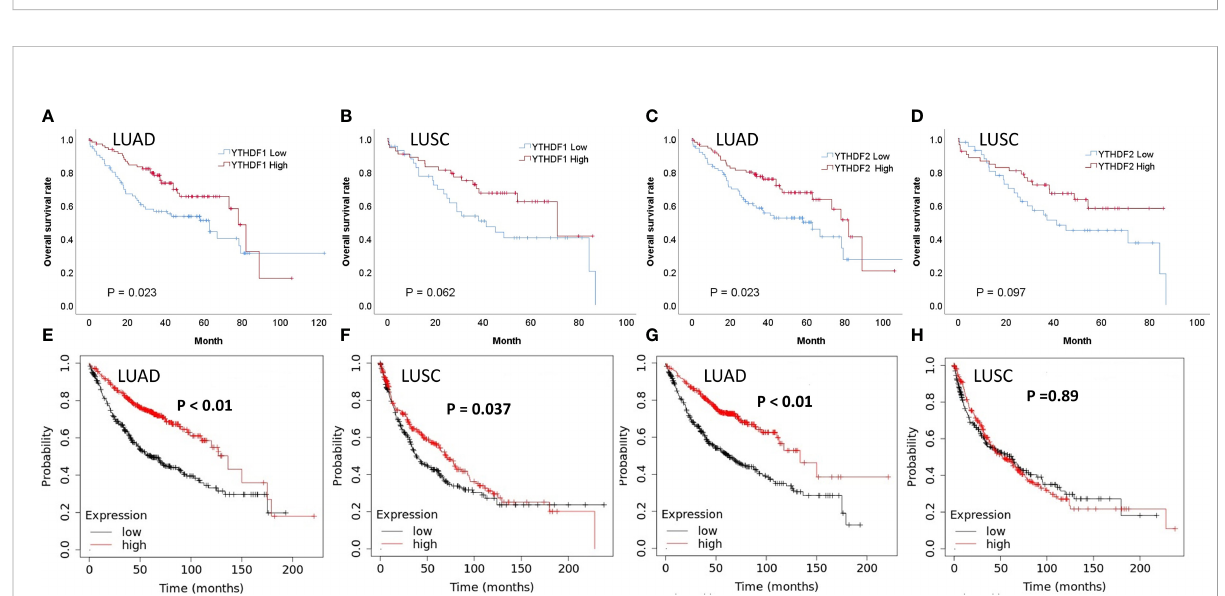
FIGURE 4 Survival analyses according to YTHDF1 and YTHDF2 expression in patients not receiving PD-1/PD-L1 inhibitors. (A) Overall survival (OS) and immunohistochemical expression of YTHDF1 in lung adenocarcinoma (LUAD). (B) OS and immunohistochemical expression of YTHDF1 in lung squamous cell carcinoma (LUSC). (C) OS and immunohistochemical expression of YTHDF2 in LUAD. (D) OS and immunohistochemical expression of YTHDF2 in LUSC. (E) OS and mRNA expression of YTHDF1 in LUAD. (F) OS and mRNA expression of YTHDF1 in LUSC. (G) OS and mRNA expression of YTHDF2 in LUAD. (H) OS and mRNA expression of YTHDF2 in